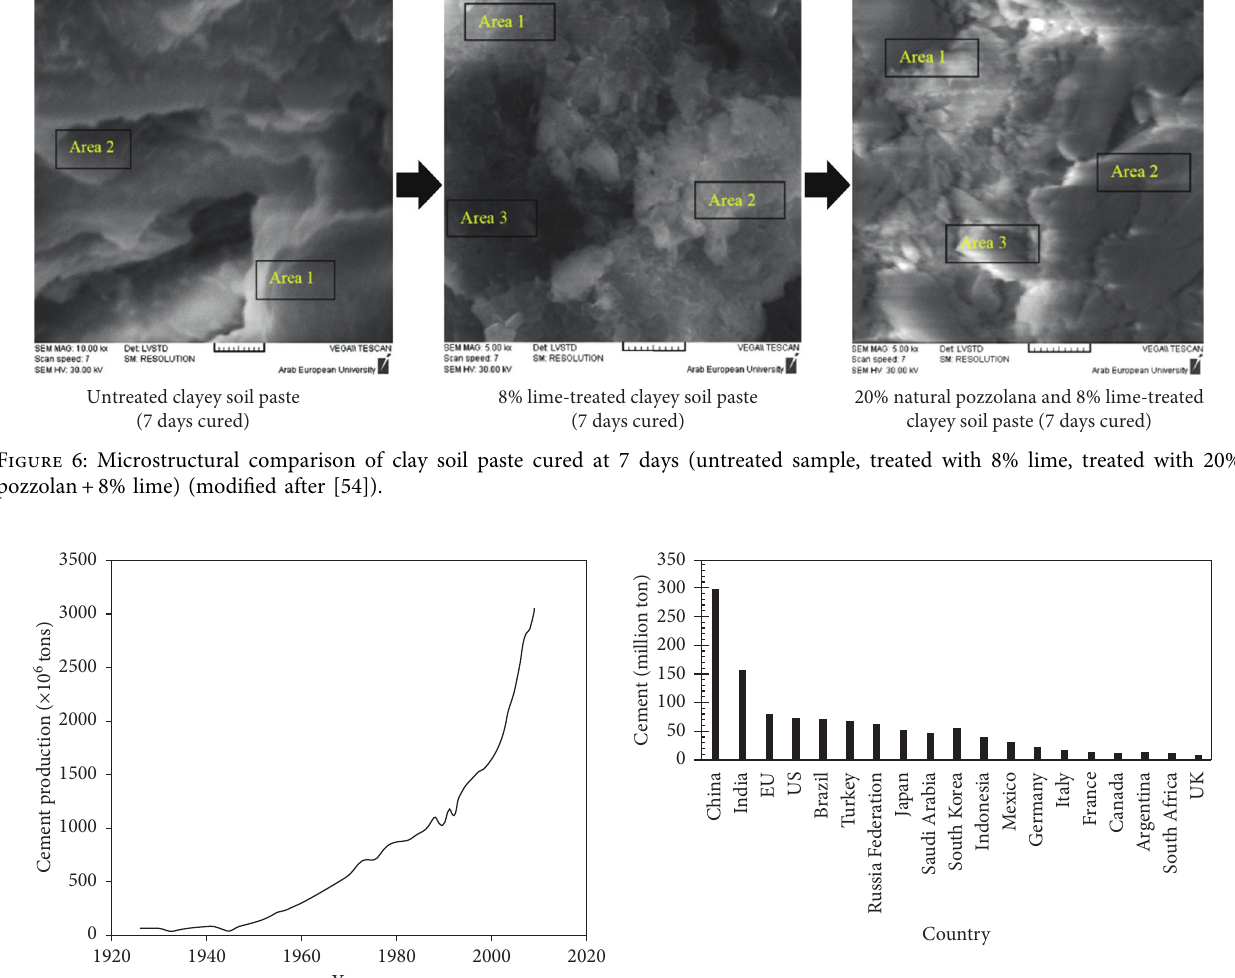
Figure 7: Global annual cement production: (a) between 1925–2009 [124]; (b) in different countries [125].